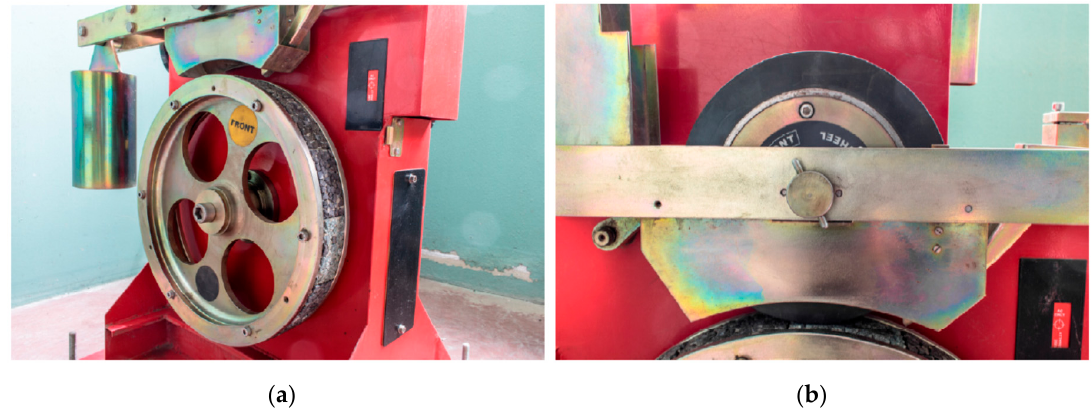
Figure 4. Accelerated polishing machine: ( a ) revolving wheel; ( b ) polishing tire-wheel by corn emery. Each specimen was marked with an arrow indicating the profilometer reading direction during the microtexture analysis and placed by matching this direction and the wheel rotation direction.